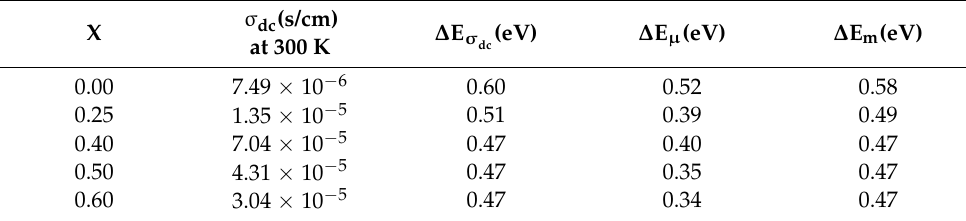
Table 1. The dc conductivity values for Li 5+2x La 3 Nb 2 − x Sm x O 12 garnets at 300 K. ∆ E σ ∆ E m are the activation energies for conduction, mobility and relaxation process, respectively.